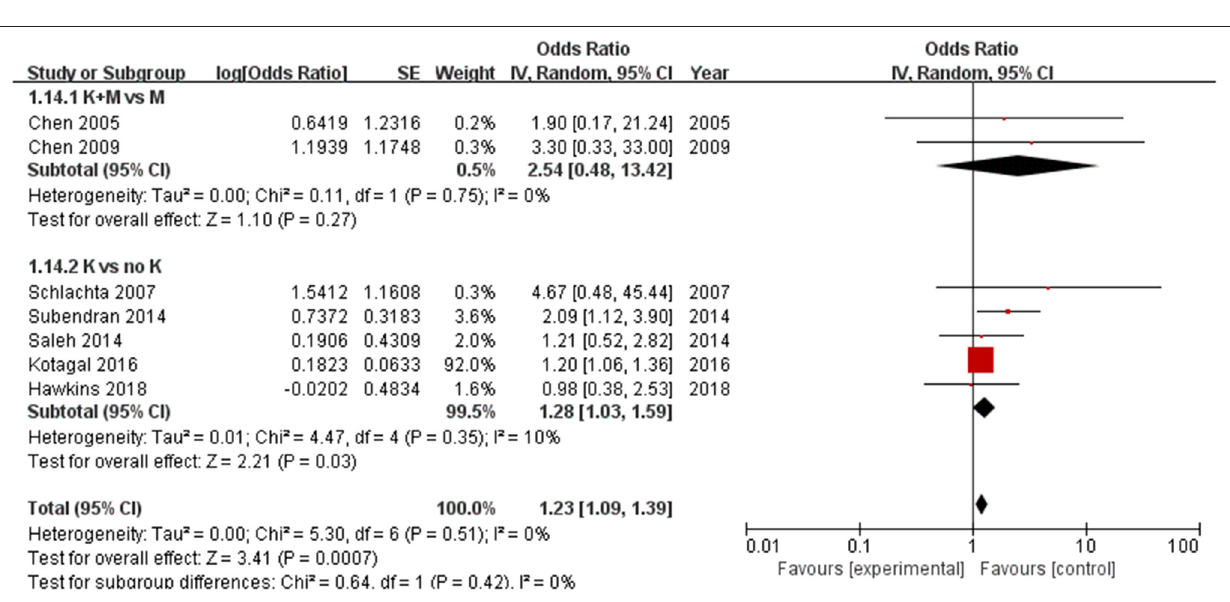
FIGURE 4 | Forest plots of subgroups according to different study designs: 1.14.1 K + M (ketorolac plus morphine) vs . K (ketorolac); 1.14.2K (ketorolac) vs . (no ketorolac).